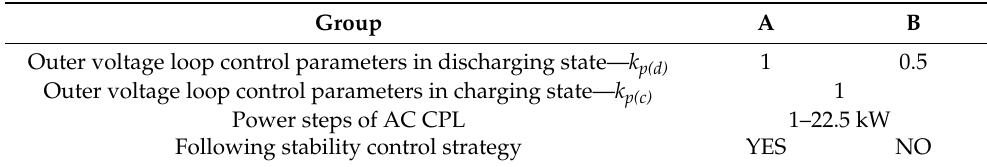
Table 2. Comparison parameters of experiments in groups A and B. Group